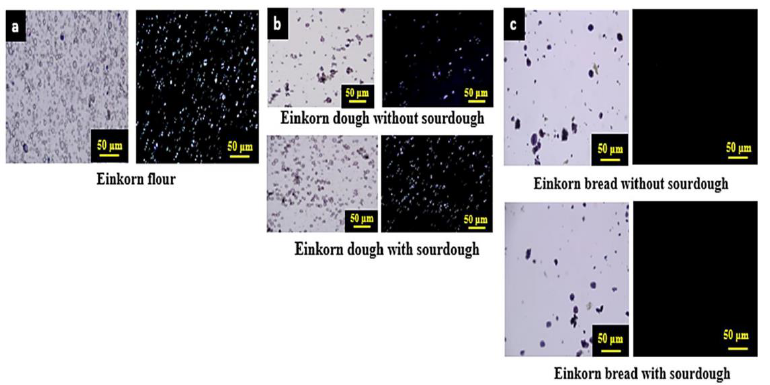
Figure 4. Starch granules from einkorn flour and bread samples with or without sourdough. Adapted from Sereti et al. [114]. Copyright 2020 Creative Common Attribution License.